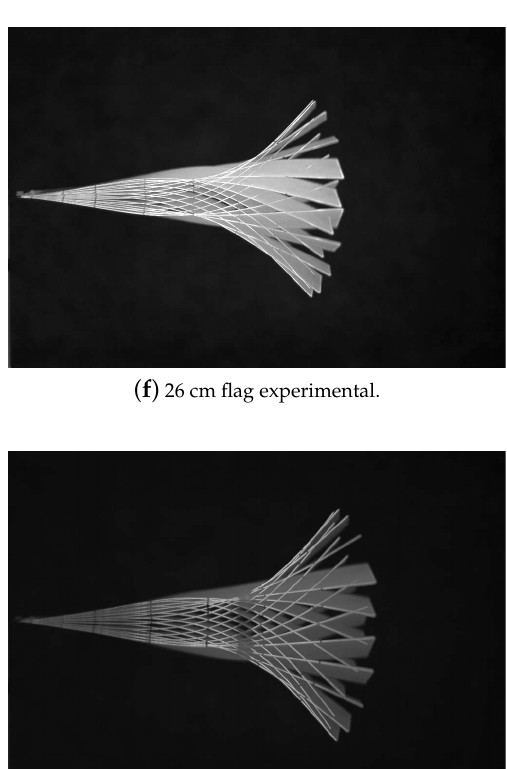
( h ) 29 cm flag experimental.